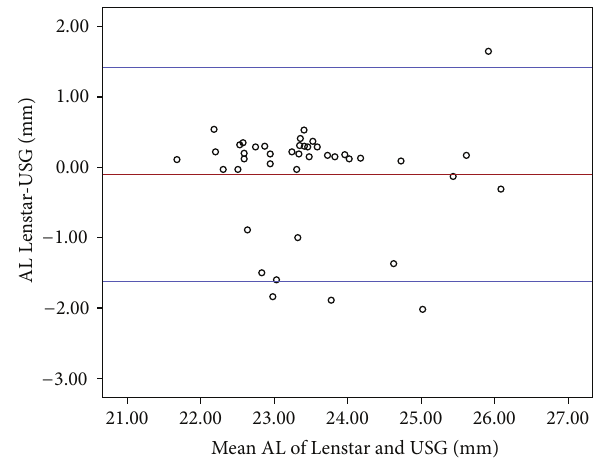
Figure 4: The Bland-Altman plot (left) showing differences in average axial length (AL) measurement of the devices. The bold horizontal line demonstrates the mean difference between the devices. The dotted lines above and below represent the 95% limits of agreement